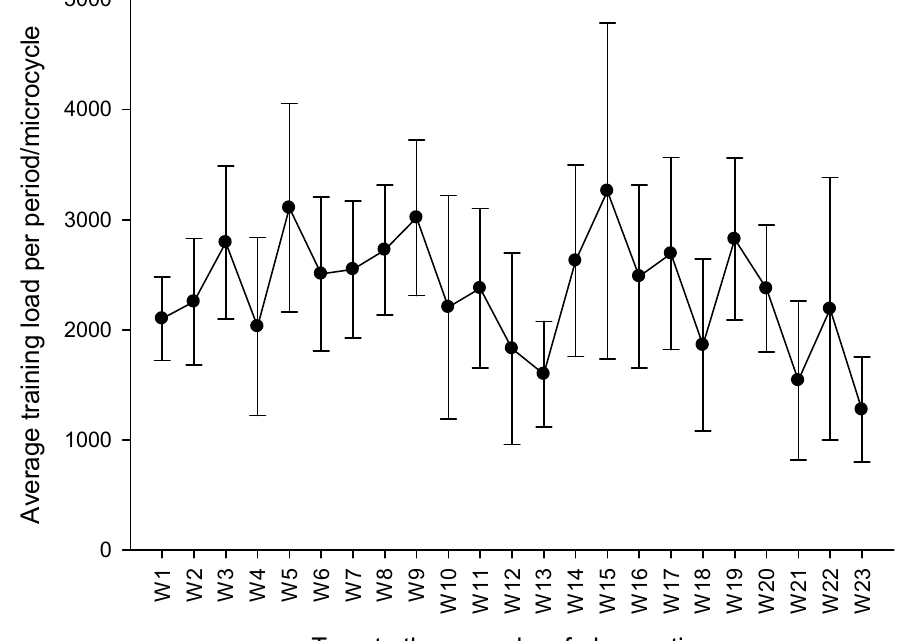
Figure 2. Average training load in the 23 weeks of observation.